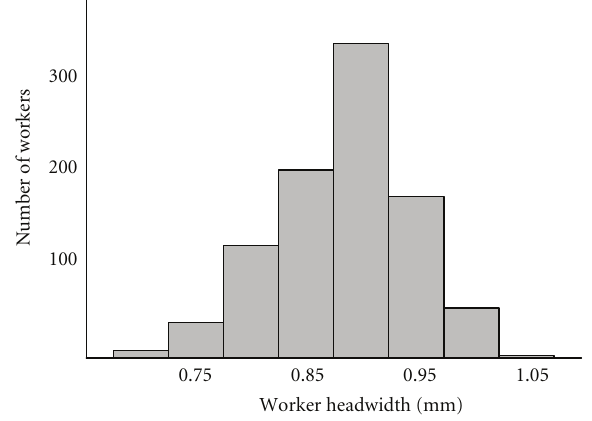
Figure 6: The distribution of the head width of 975 workers from 39 Nipmuck and Pachaug